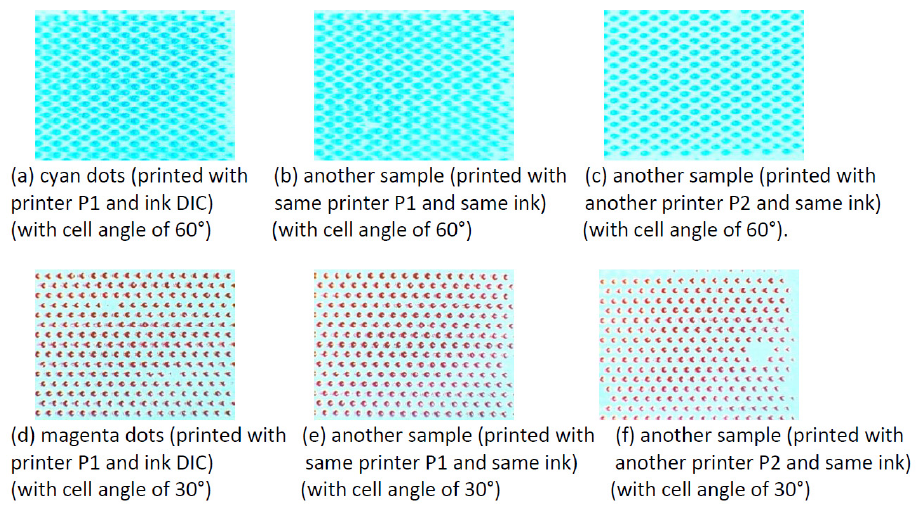
Figure 15. Robustness of the dot patterns detection method relative to the printing